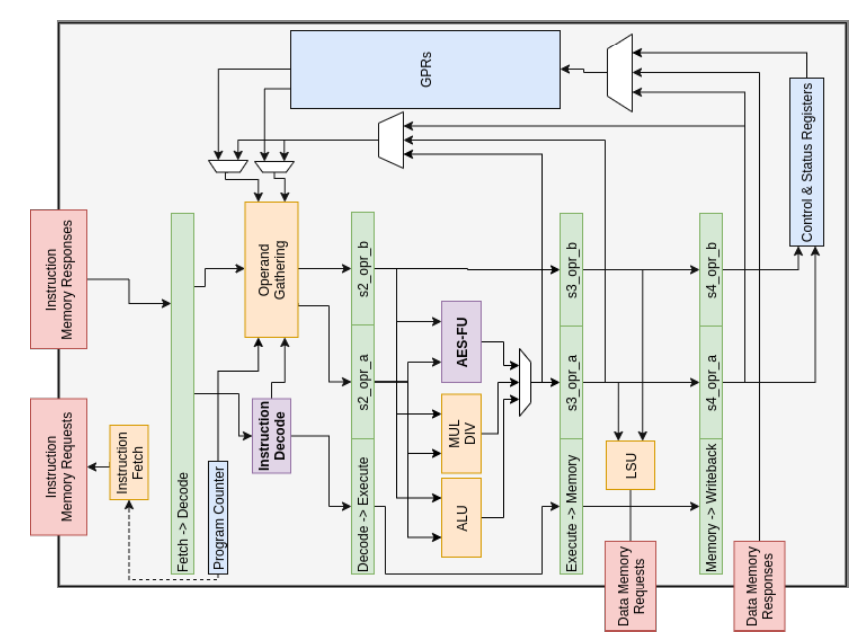
Figure 12: SCARV core micro-architecture.